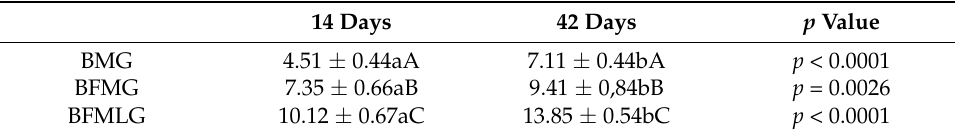
Table 1. Percentage of new bone formation in each group in the two experimental periods (14 and 42 days). BMG—defects filled with HA/ β -TCP covered by a bovine biological membrane; BFMG defects filled with HA/ β -TCP and heterologous fibrin biopolymer covered with bovine biological membrane; BFMLG defects filled with HA/ β -TCP and heterologous fibrin biopolymer covered with bovine biological membrane and PBMT.